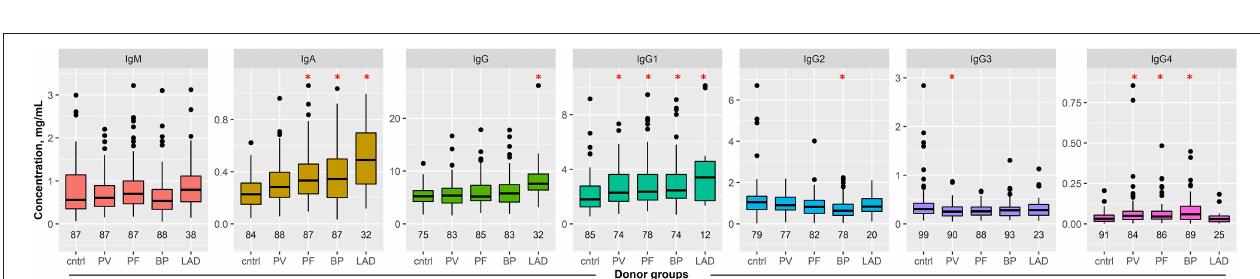
FIGURE 1 | Impact of age and sex on serum immunoglobulin (Ig) concentrations in healthy blood donors. Serum concentration of IgM, IgA, IgG, and IgG1–4 was determined in healthy blood donors by ELISA. (A) The median age of the entire cohort was 69 years. To determine the impact of age on serum Ig concentration, these were compared between healthy subjects aged < 69 years to those 69 years or older. In elderly healthy blood donors, IgM and IgG serum concentrations were decreased, while all immunoglobulin levels, with the exception of IgG4, were increased. (B) When stratified by sex, decreased IgM concentrations were noted in male healthy blood donors. All other serum Ig concentrations were similar between female and male healthy blood donors. Data are shown as median (black line) and 25/75 percentiles (boxes); the whiskers extend no further than 1.5 × IQR from a hinge (where IQR is the interquartile range), and outliers (points). Welch test was used to test for statistically significant differences among the groups.